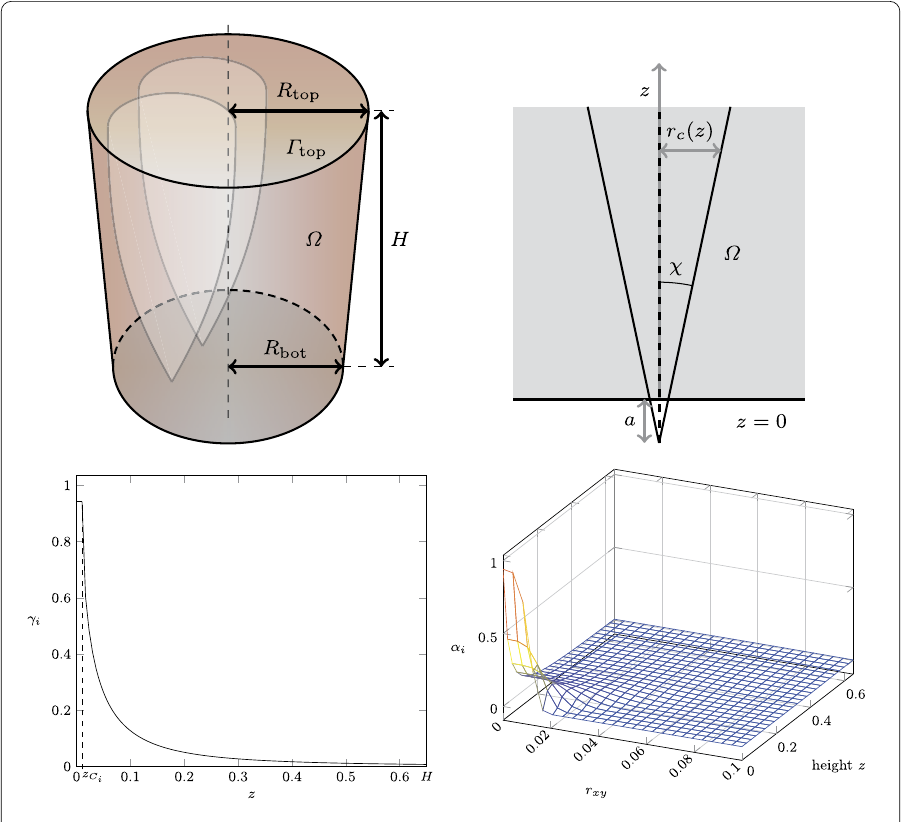
Figure 1 Relevant entities in the definition of the buoyancy force. Top left: Sketch of the 3d ladle with two eccentric nozzles; top right: The function r c ; bottom: The functions γ i ( · , z ) (left) and α i ( · , x , y , z ) (right) for a constant gas flow rate Q i = 17 l . min –1 (as in Table 1), where r xy is the horizontal distance to the nozzle, i.e., r 2 xy = ( x – x ni ) 2 + ( y – y ni ) 2